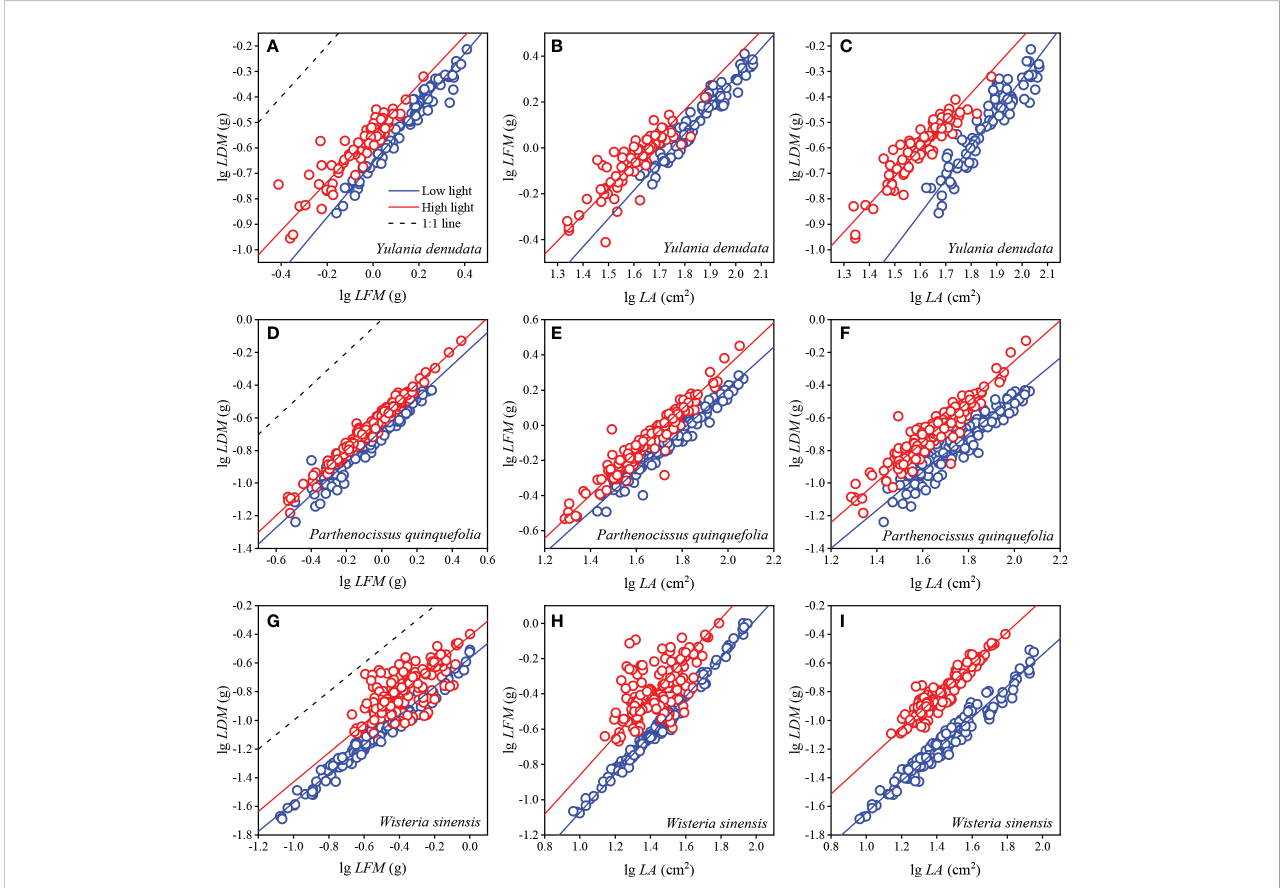
FIGURE 1 Scaling relationships between leaf traits in different urban plants. (A – C) represent the fi tting relationship between LDM with LFM , LFM with LA , and LDM with LA of Y. denudata leaves, respectively. (D – F) represent the fi tting relationship between LDM with LFM , LFM with LA , and LDM with LA of P. quinquefolia leaves, respectively. (G – I) represent the fi tting relationship between LDM with LFM , LFM with LA , and LDM with LA of W. sinensis leaves, respectively. Circles represent the observed values; the blue and red solid lines represent SMA fi tting lines between leaf traits under low and high light habitats, respectively; and dotted lines represent 1:1 line. Some 1:1 lines are not shown due to the proportional value of the axes.